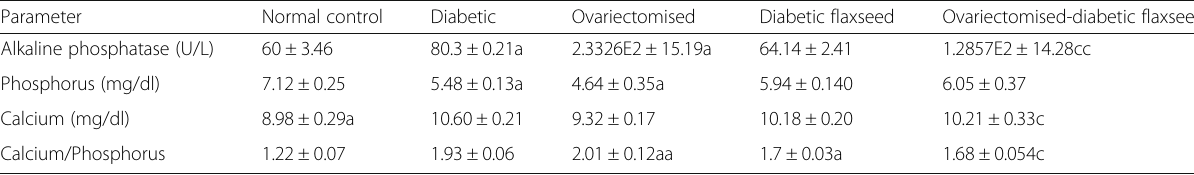
Table 1 Biochemical parameters level in different groups studied Parameter Normal control